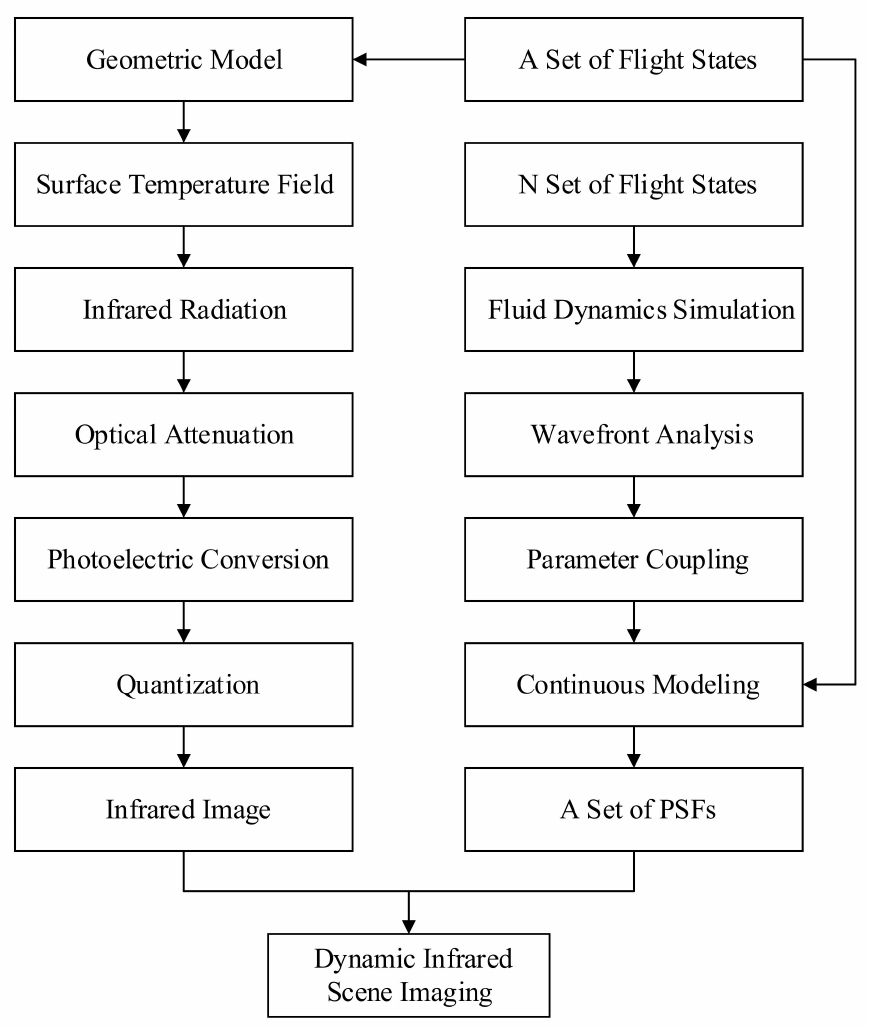
Figure 1. Flowchart of the proposed